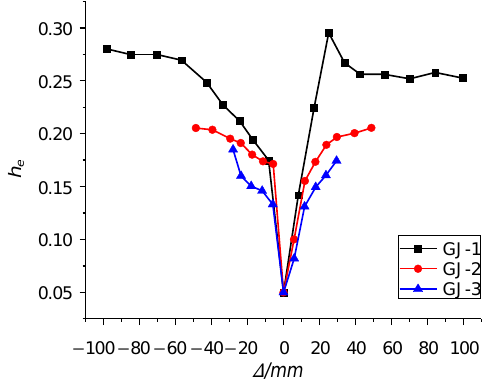
Figure 11. Equivalent viscous damping coefficient.